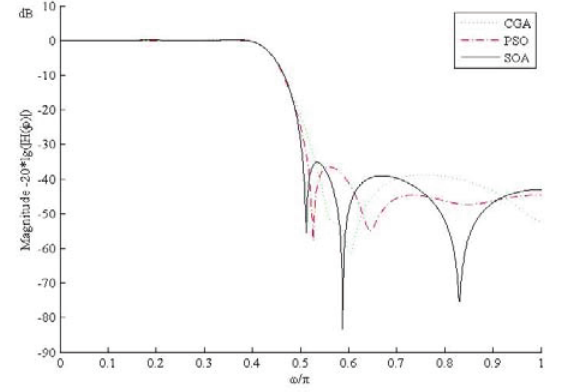
Figure 4. Frequency responses of IIR digital filters